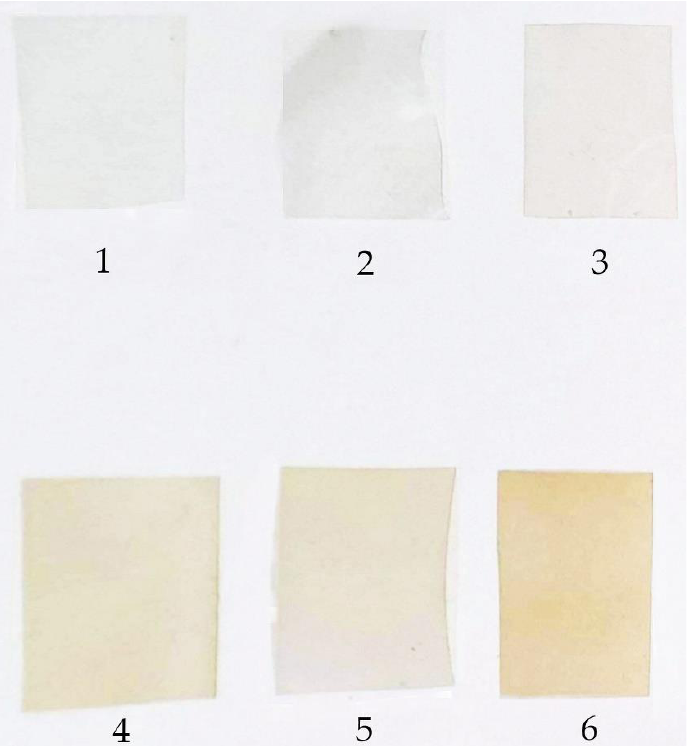
Figure 4. The visual appearance of CMC-based films. 1 –CMC; 2 –CMC + CV; 3 –CMC + 0.1 M; 4 –CMC + 0.5 M; 5 –CMC + 0.1 M +CV; 6 –CMC + 0.5 M + CV.